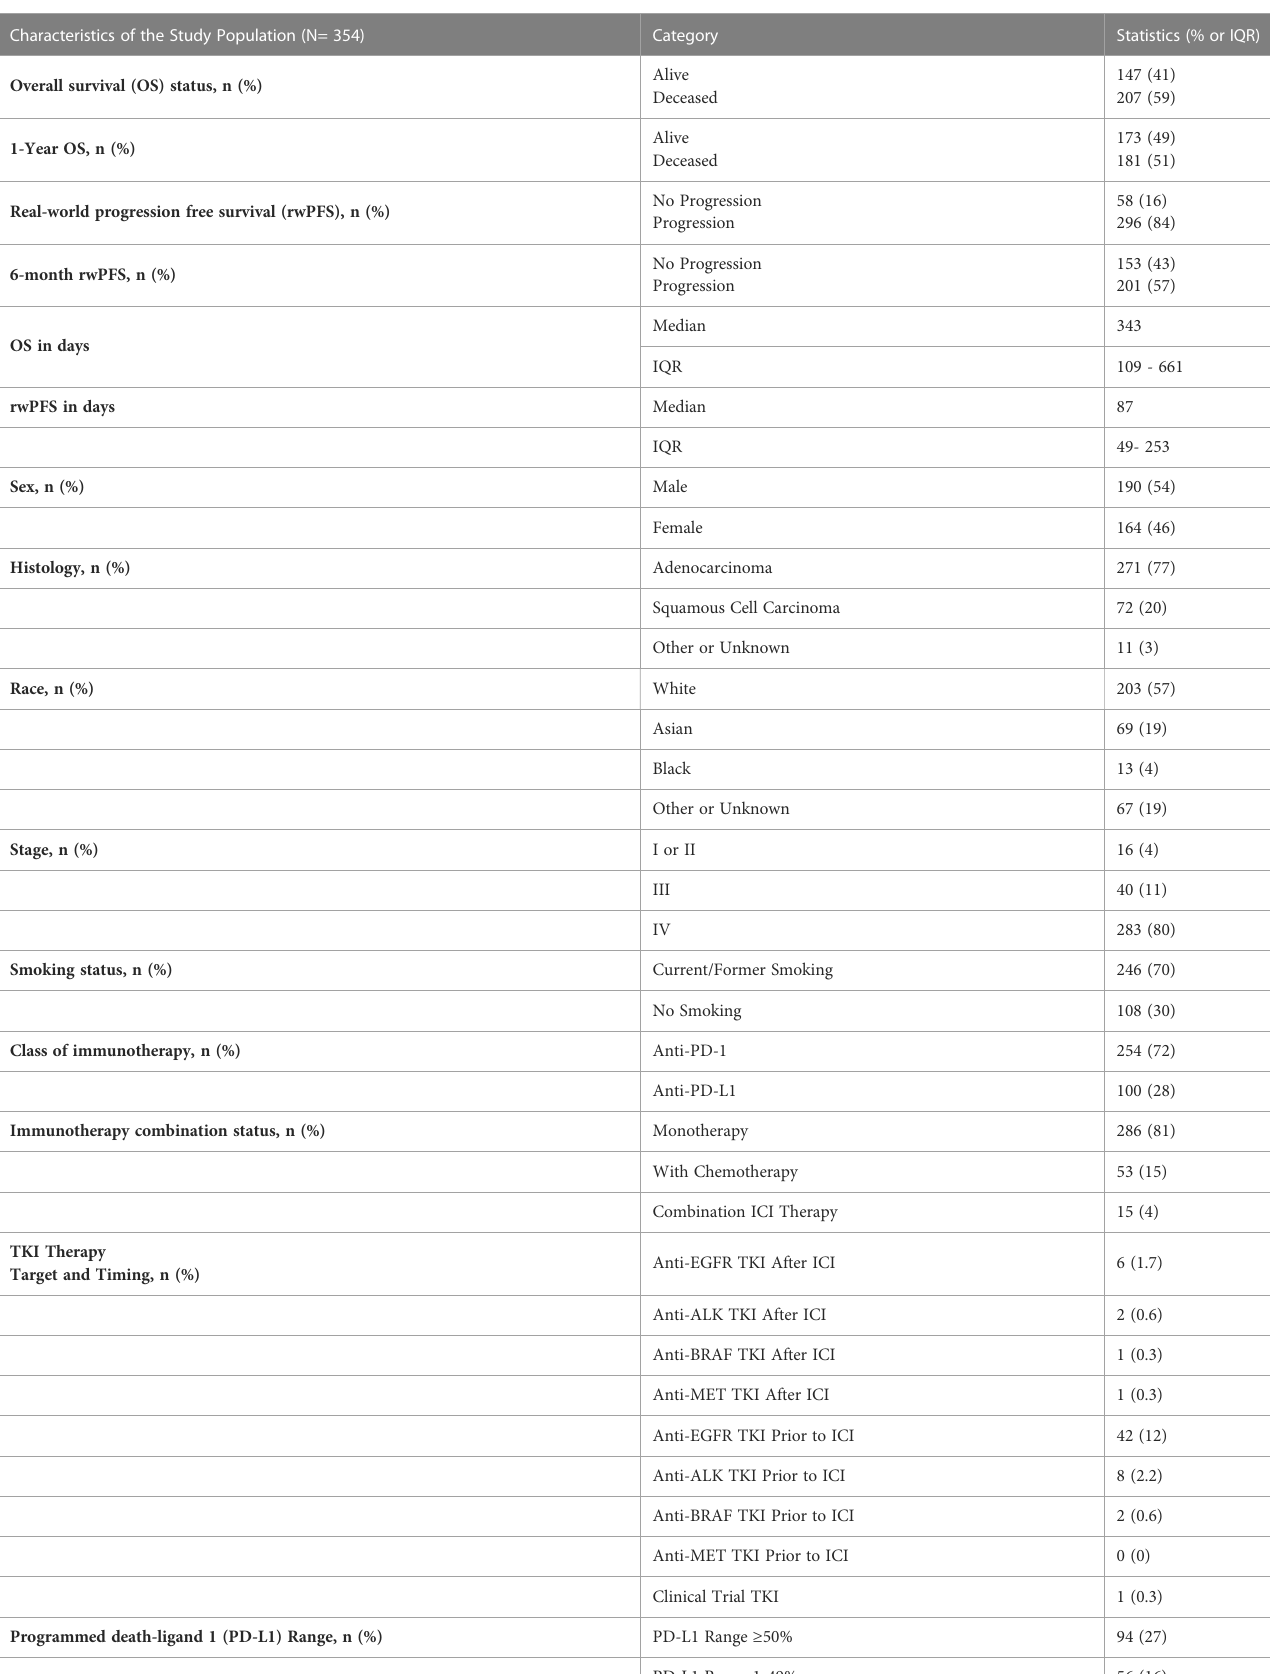
TABLE 1 Characteristics of patient population identi fi ed from the retrospective chart